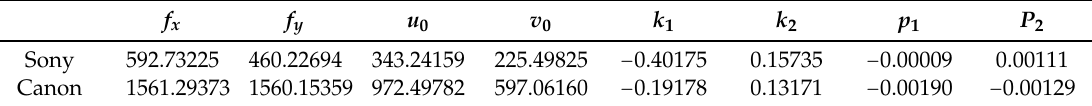
Table 4. Intrinsic parameters of the vision sensors Table 4 . Intrinsic parameters of the vision sensors